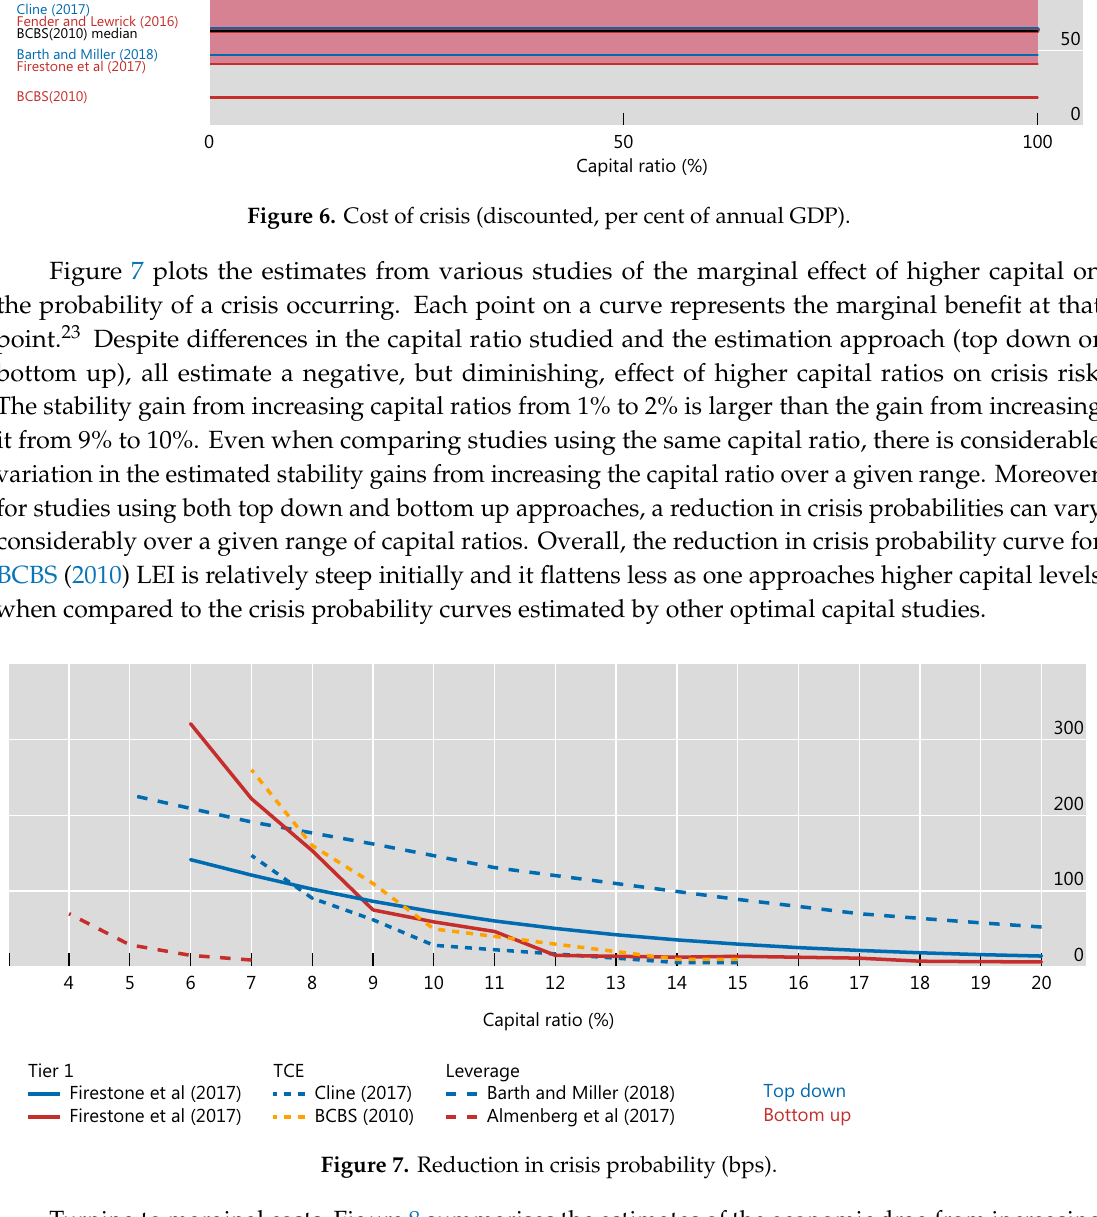
Figure 7. Reduction in crisis probability (bps).